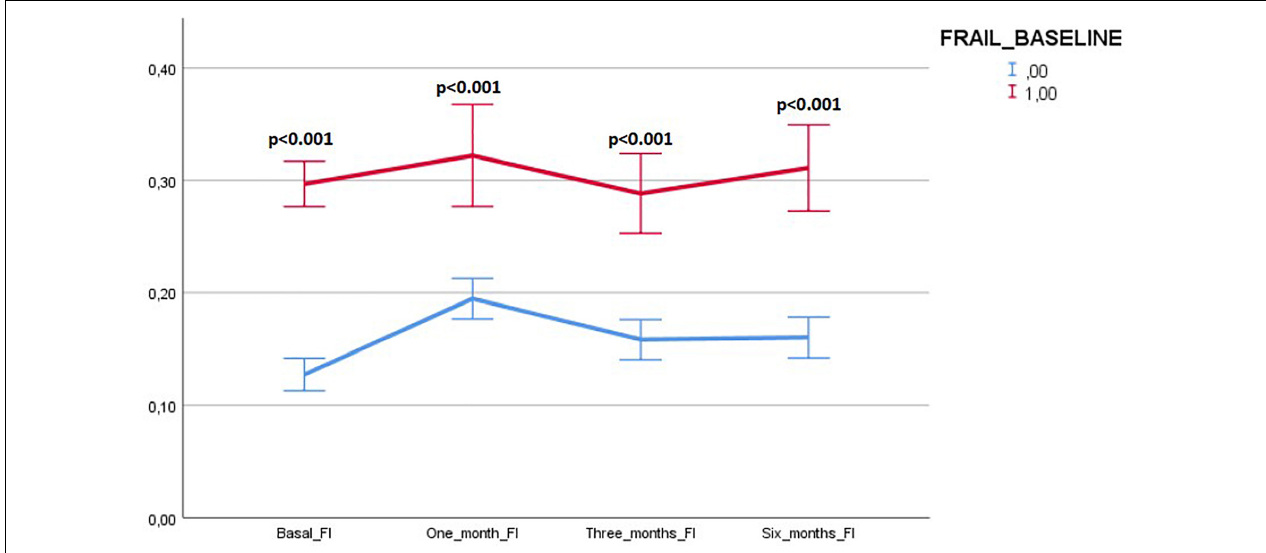
FIGURE 5 | Variations in frail and robust patients of the number of persisting and de-novo long COVID-19 symptoms during the follow-up. Results expressed as means and 95%